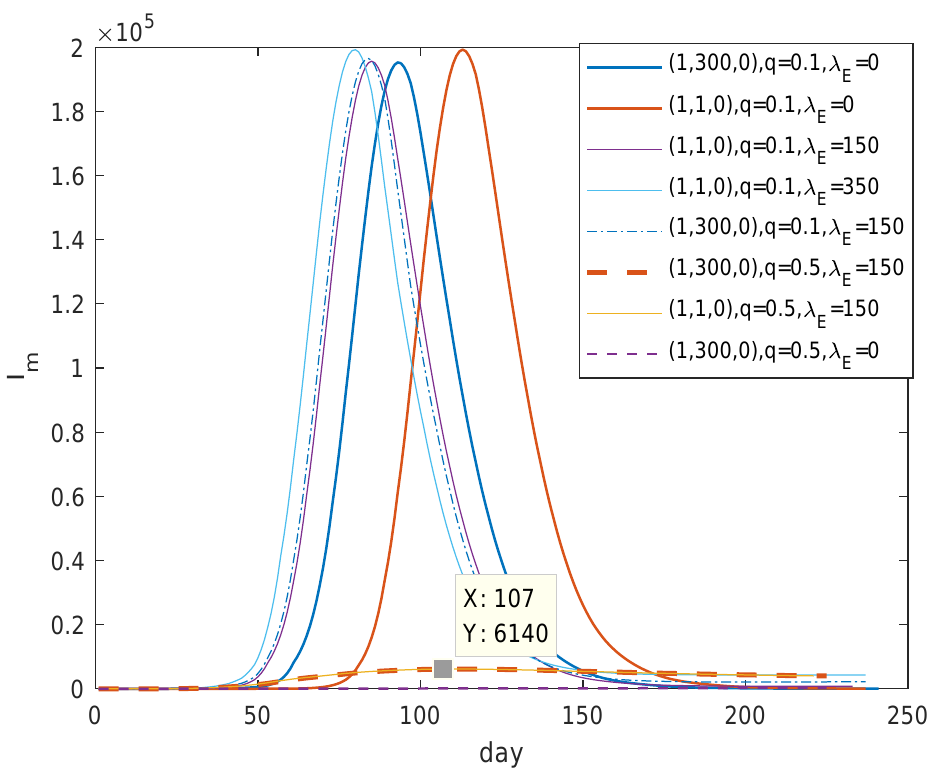
Figure 11. Recurrence for the existence of undiscovered infected persons. After reopening, the Fig. 11: Recurrence for the existence of undiscovered infected persons recurrence is inevitable if there is an unexposed infected individual. The improved tracking rate can contribute to contain the next outbreak. Upper mark of ( 1,1,0 ) denotes the initial value of ( E , I a , I m )